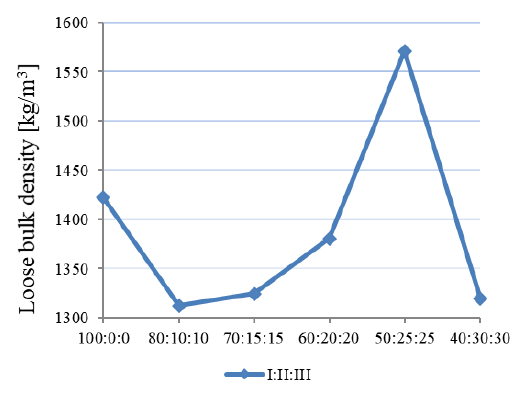
Figure 3. Maximum loose bulk density of RCA